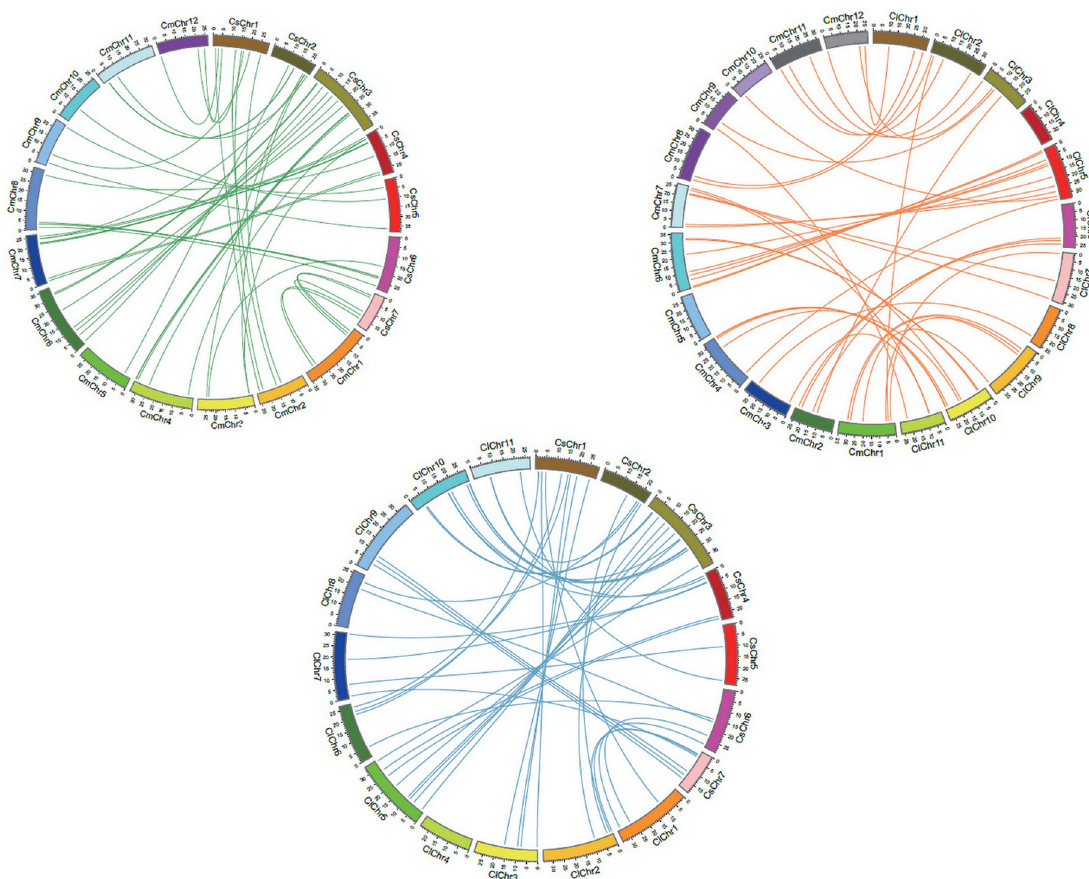
Fig 4. Comparative analysis of orthologous relationship among three cucurbitaceae species for WRKY genes. Each chromosome was represented with different colour. Green lines indicate homologous genes between melon and cucumber chromosomes, orange lines indicate homologous genes between melon and watermelon chromosomes, blue lines indicate homologous genes between cucumber and watermelon chromosomes.